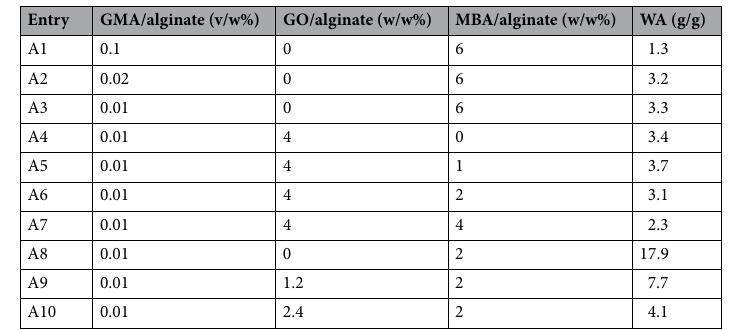
Table 1. Different SA-based hydrogel samples prepared via changing feeding ratios of GMA monomer, MBA cross-linker, and GO nano-filler and their water absorbencies.